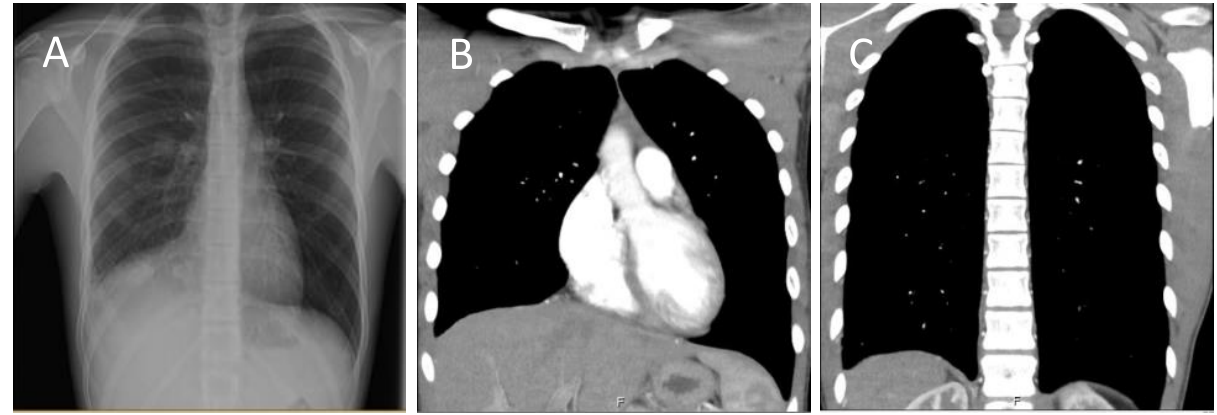
Figure 2. A: Progressive resolution of fluid collection, B: complete resolution of fluid collection 3 months after discharge, C: complete resolution of posterior fluid collection 3 months after discharge.